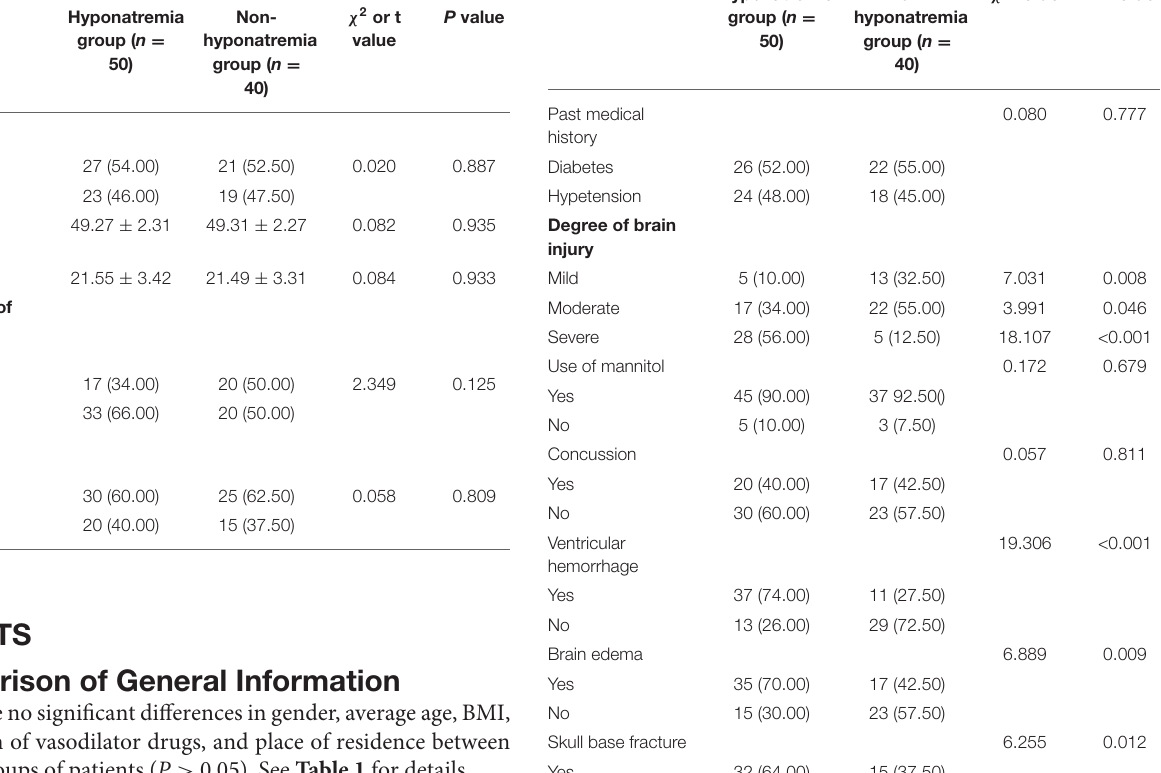
TABLE 1 | Comparison of general information of the two groups of patients [(mean, SD), n (%)]. Hyponatremia group ( n =